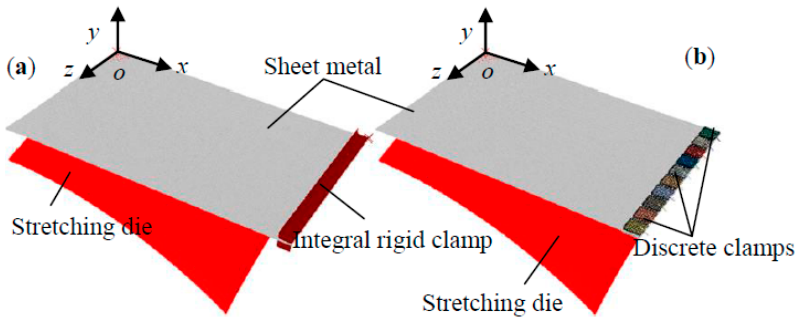
Figure 4. A quarter FE model of stretch-forming. ( a ) C-SF; ( b ) UC-SF.